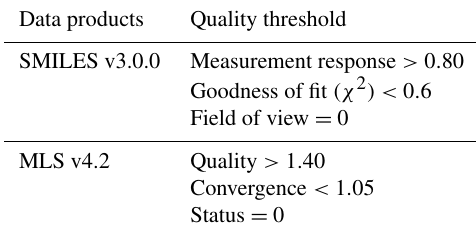
Figure 6. (a) Vertical profiles of CH 3 CN from AOS1 and AOS2 and the sum of AOS1 and AOS2 in the equatorial region from 20 ◦ S to 20 ◦ N, from March until April 2010. Each line indicates the averaged VMR from AOS1 observations (red line), AOS2 ob- servations (blue line), and the sum of AOS1 and AOS2 observa- tions (gray line). (b) The absolute difference between AOS1 and AOS2 (AOS1 − AOS2). (c) The relative difference between AOS1 and AOS2 ((AOS1 − AOS2) /M when M is (AOS1 + AOS2) / 2).